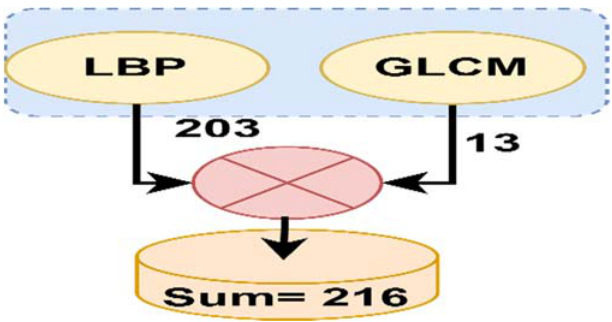
Figure 5. Hybrid LBP and GLCM algorithms.